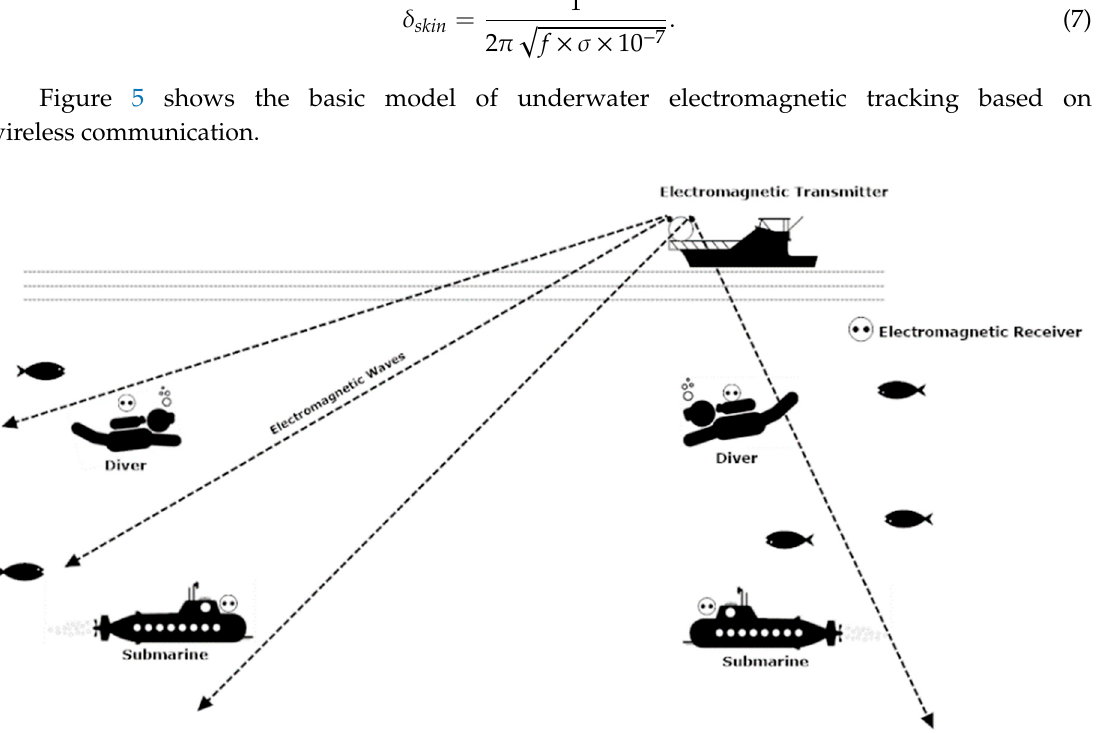
Table 4. Performance of electromagnetic waves in seawater [40].